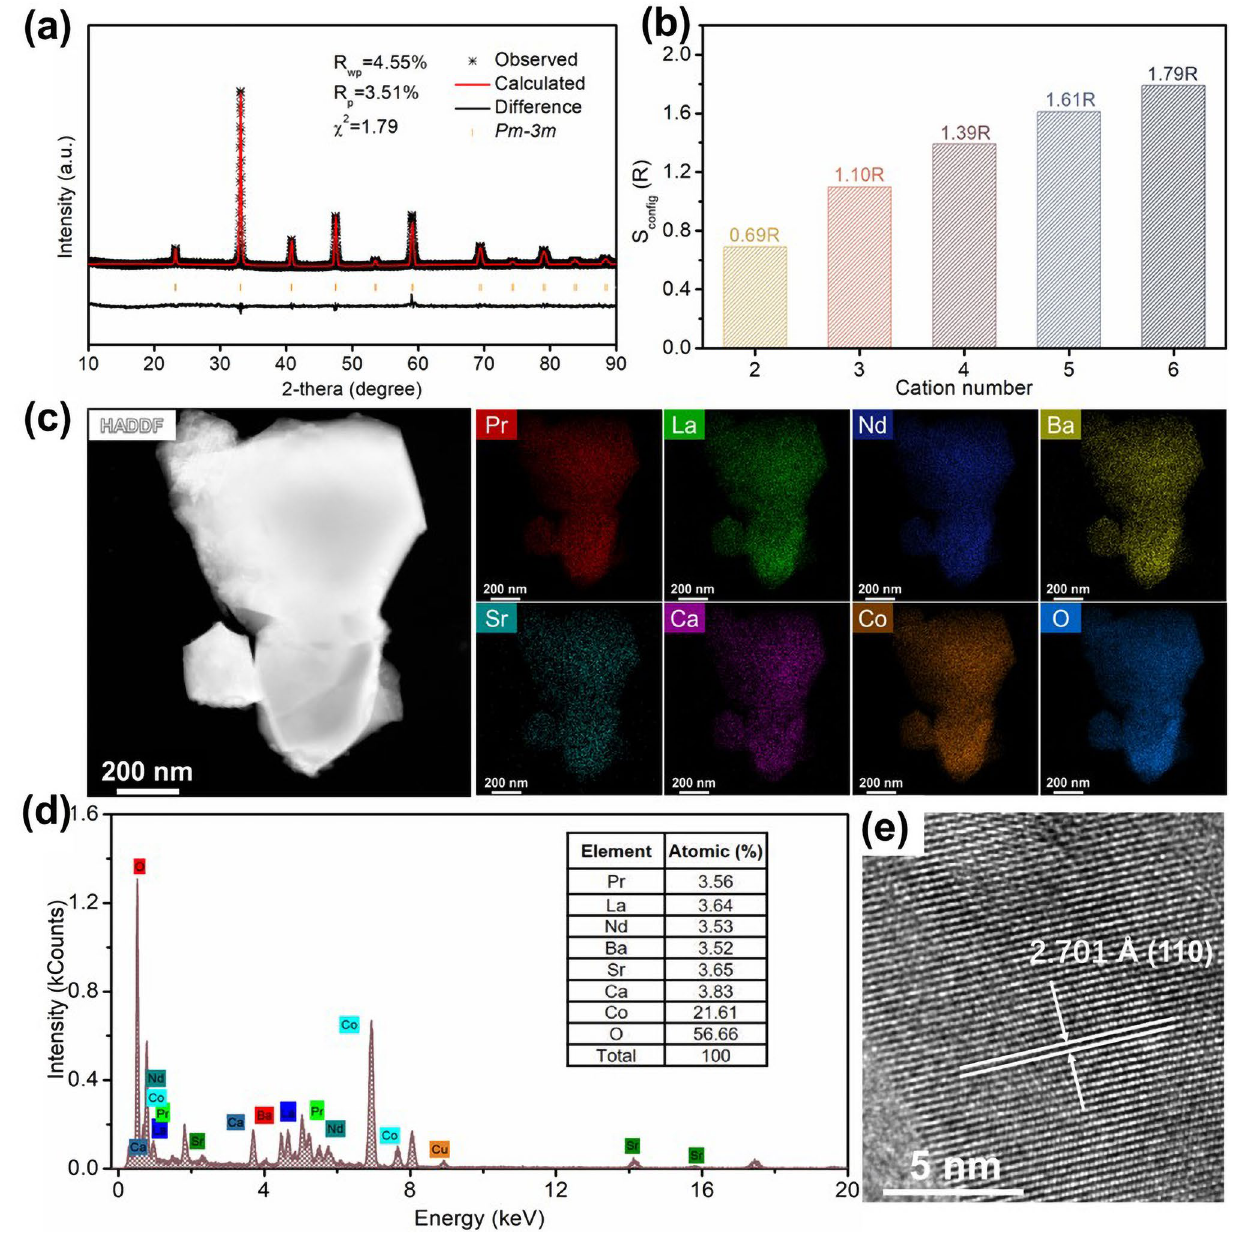
Fig. 1 a Refined XRD profile of PLNBSCC powder. b Dependence of the maximum configurational entropy of metal oxide systems on the number of cations contained. c TEM image and EDX elemental mapping of PLNBSCC powder. d EDX spectra of PLNBSCC particle in